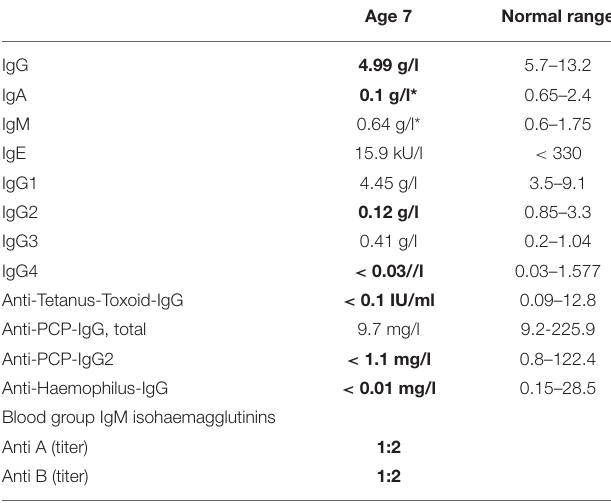
TABLE 1A | Total and specific immunoglobulin levels in the patient with CD70 deficiency prior to IgG